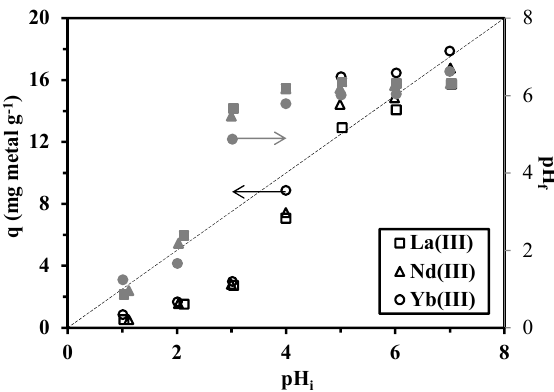
Figure 6. Effect of pH on the sorption of La(III), Nd(III) and Yb(III) ions using cysteine-functionalized chitosan magnetic nano-based particles ( C i = 100 mg·L − 1 ; T = 300 K; t = 4 h; m = 0.05 g; V = 100